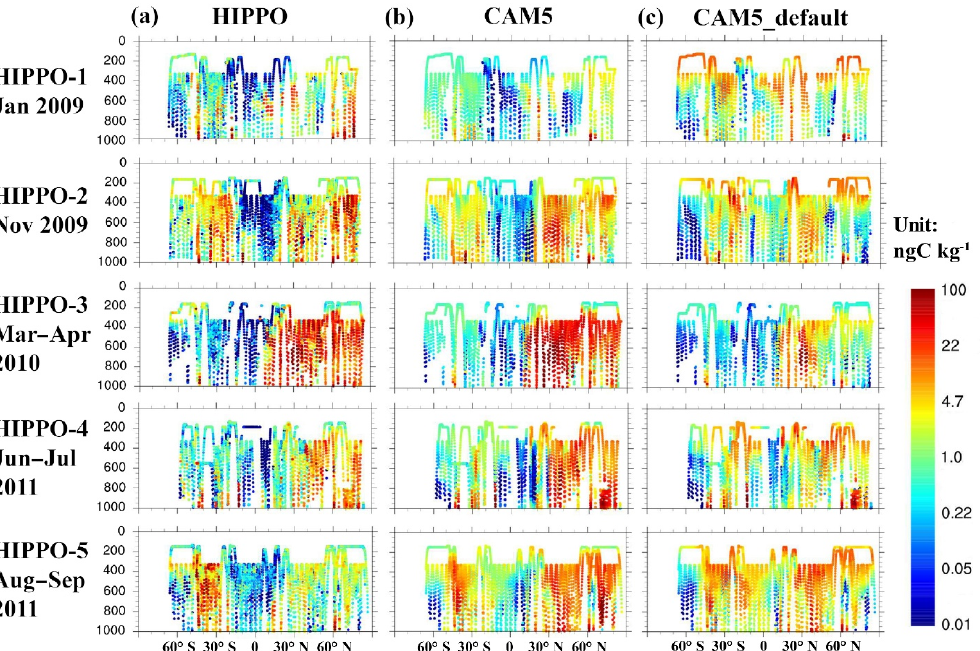
Figure 4. Comparison of HIPPO BC (ngCkg − 1 ) measurements (a) , simulated BC data from the modified CAM5 model (b) and simulated BC data from the default CAM5 model (c) during HIPPO-1 to HIPPO-5. The five rows from top to bottom are HIPPO-1 (January 2009), HIPPO-2 (November 2009), HIPPO-3 (March–April 2010), HIPPO-4 (June–July 2011) and HIPPO-5 (August–September 2011), respec- tively. Measurement data along the flight tracks of Fig. 3 are 1min averages. Model data are selected corresponding to the location and time of aircraft measurements.